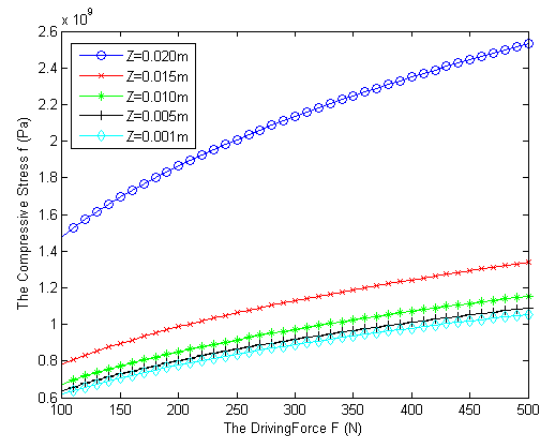
Figure 7. The relationship between the driving force and the maximum compressive stress under different depths of propulsion.